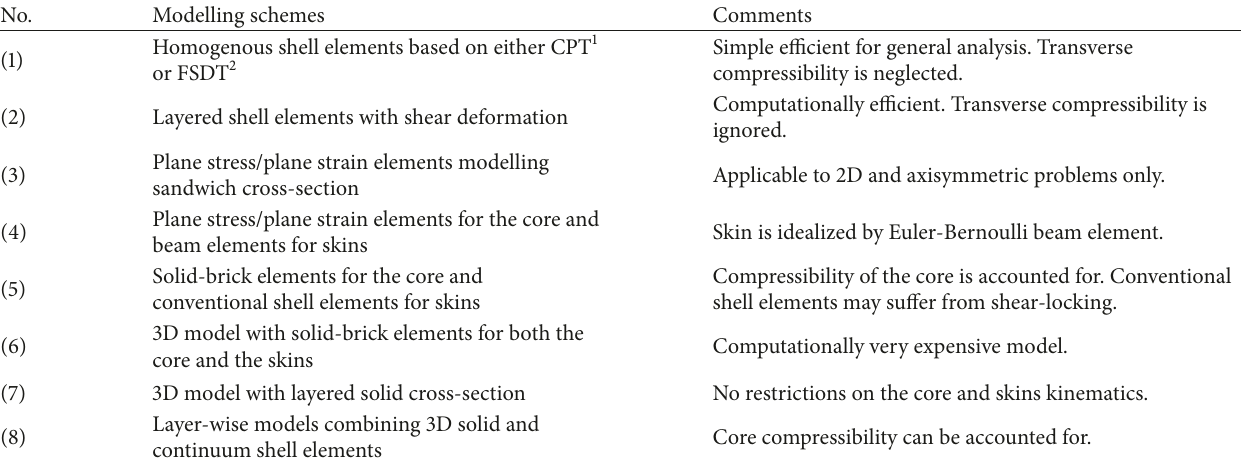
Table 1: Summary of techniques on finite element modelling of sandwich panels [11, 12].